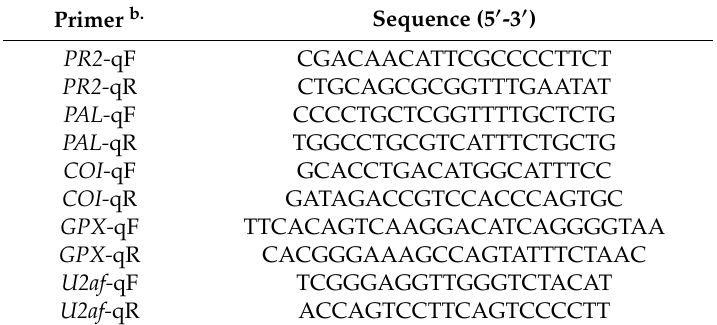
Table 2. The qRT-PCR primer pairs of P. massoniana defense resistance-related genes. Primer b. Sequence (5 (cid:48) -3 (cid:48)